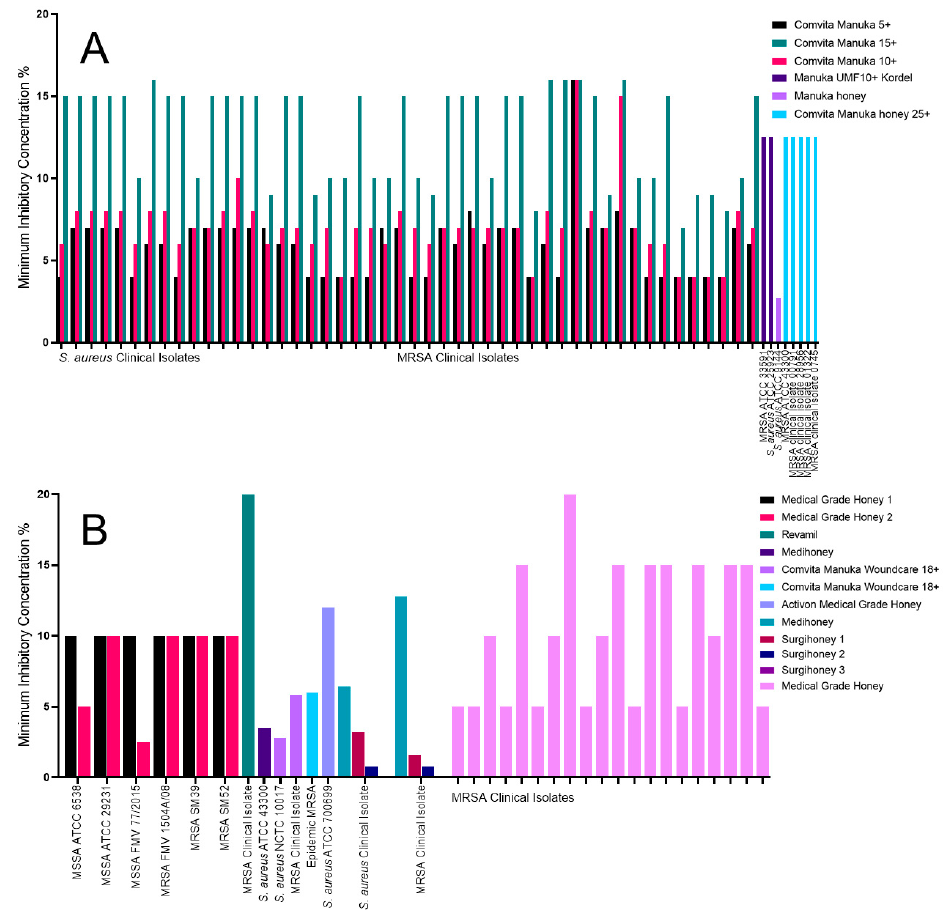
Figure 1. MICs of the S. aureus isolates tested against a variety of Manuka and medical-grade honeys. ( A ) All the Manuka honey MIC data used in this review, identifying Manuka honey and Comvita Manuka honey UMF5 + as the most e ff ective; and ( B ) all the medical-grade honey MIC data used in this review, identifying all three Surgihoneys as the most e ff